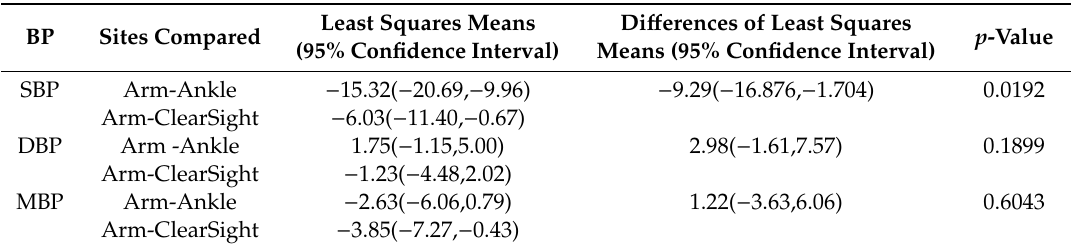
Table 3. Di ff erence between Arm–Ankle and Arm–ClearSight compared using a linear mixed model.